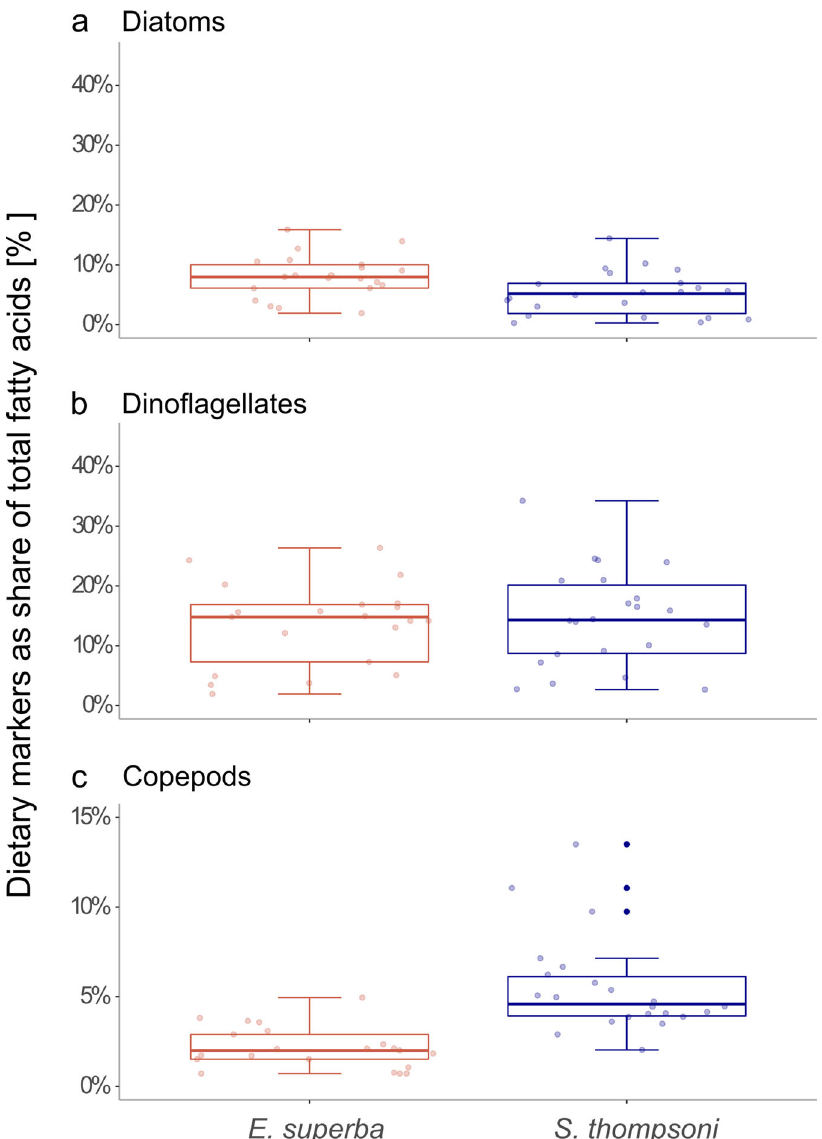
Fig. 5 Marker fatty acids for major plankton groups. Fatty acids were identi fi ed from the tissue of krill ( n = 21) and salps ( n = 22). The sum of marker fatty acids for three plankton groups: ( a ) diatoms, ( b ) dino fl agellates, and ( c ) calanoid copepods as percentage of total fatty acids is shown on the y-axis for krill (red) and salps (blue), respectively. Dots represent individual